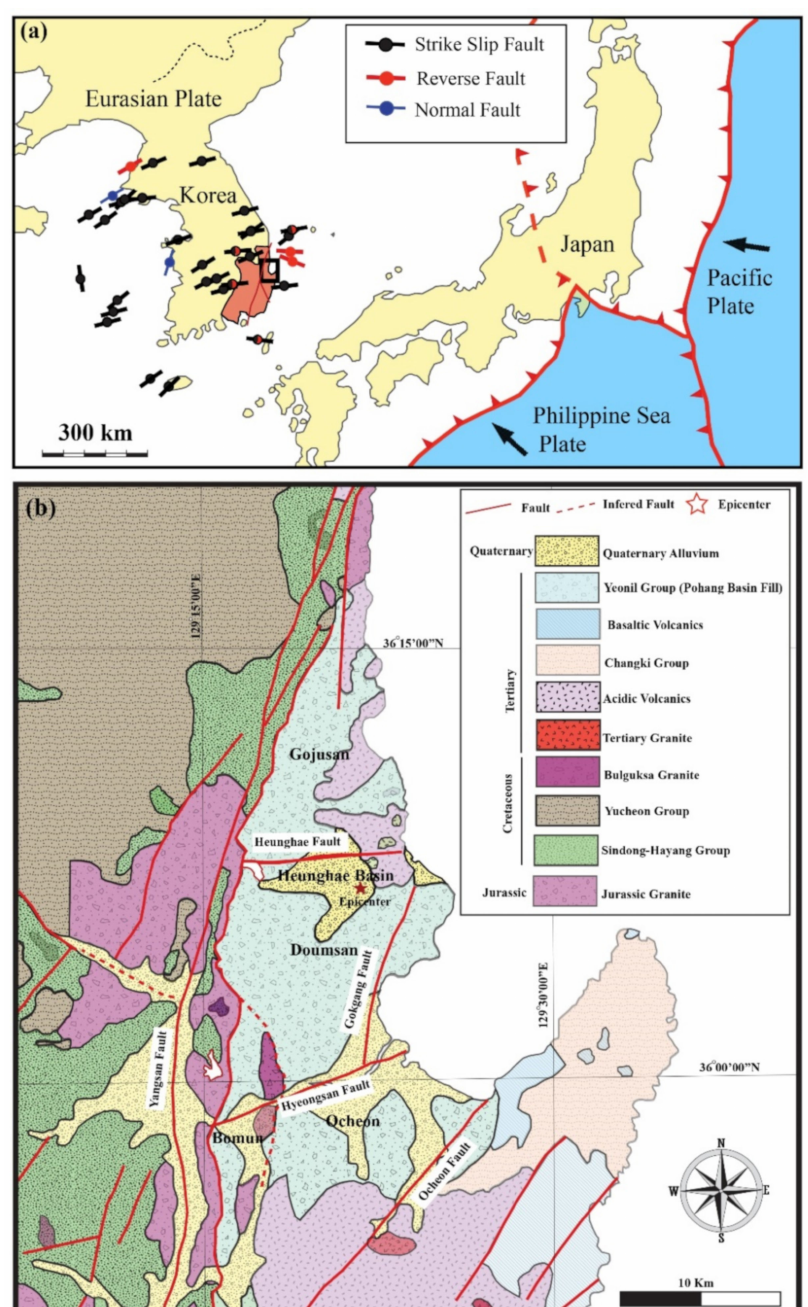
Figure 1. ( a ) Regional tectonic map of the study area. Bars indicate the maximum stress directions with major faulting type using past earthquakes of M w > 3 (earthquake data taken from 1996 to 2014); black box shows the study area. ( b ) Geological and tectonic map of the study area showing the epicentral location of the 15 November 2017 Pohang earthquake with major fault lines (modified from